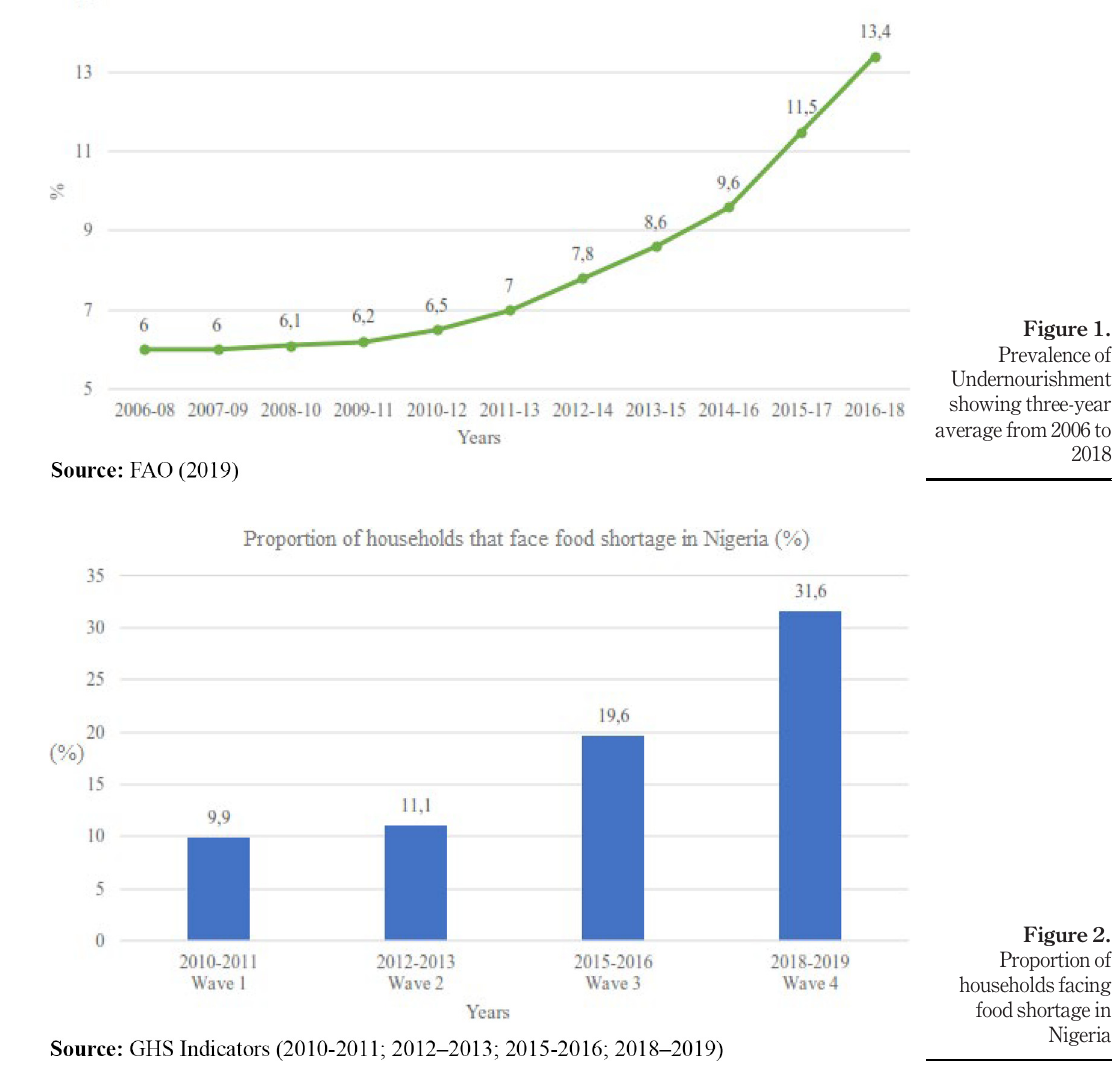
Figure 2. Proportion